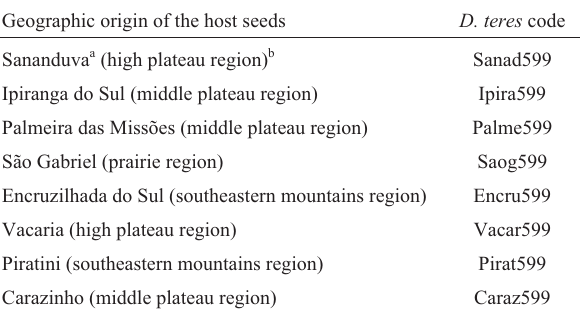
Table I - Isolation of Drechslera teres from barley seeds.